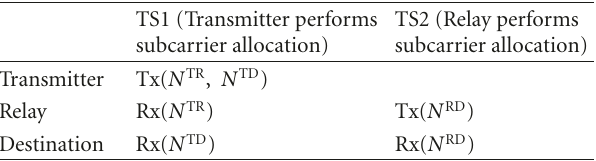
Table 1: Cooperation